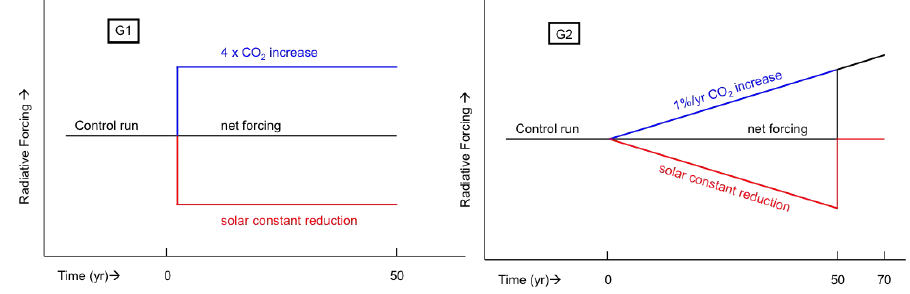
Figure 1. Schematic of GeoMIP G1 and G2 simulations, from Kravitz et al. (2011).